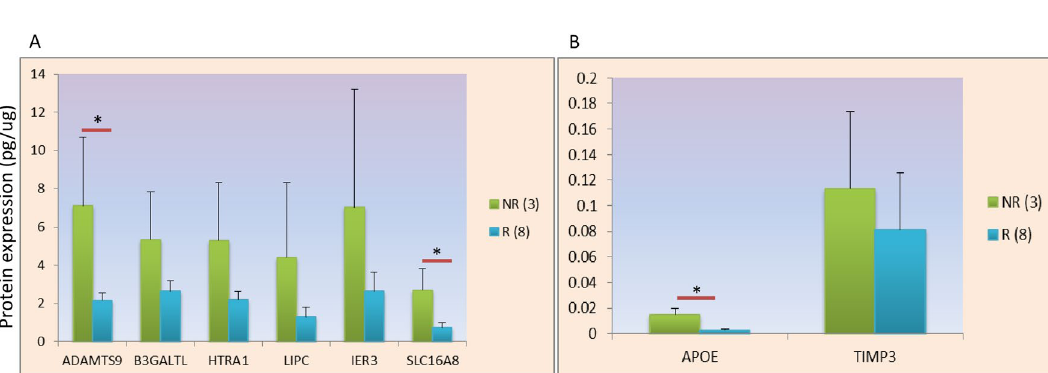
Figure 4. Differential expression of proteins in retrospectively group (Group 4). ( A ) Significant higher expression of ADAMTS9 and SLC16A8 in anti-VEGF non-responder (≥ 5 anti-VEGF injections/year), as compared to responders (≤ 4 anti-VEGF injections/year) in wet AMD patients. ( B ) APOE expression significantly higher in non-responder (≥ 5 anti-VEGF injections/year) for anti-VEGF AMD patients in comparison to responders (≤ 4 anti-VEGF injections per year). NR: non-responsive wet AMD for anti-VEGF treatment; R: responsive wet AMD for anti-VEGF treatment. Bar is representing SEM; P <